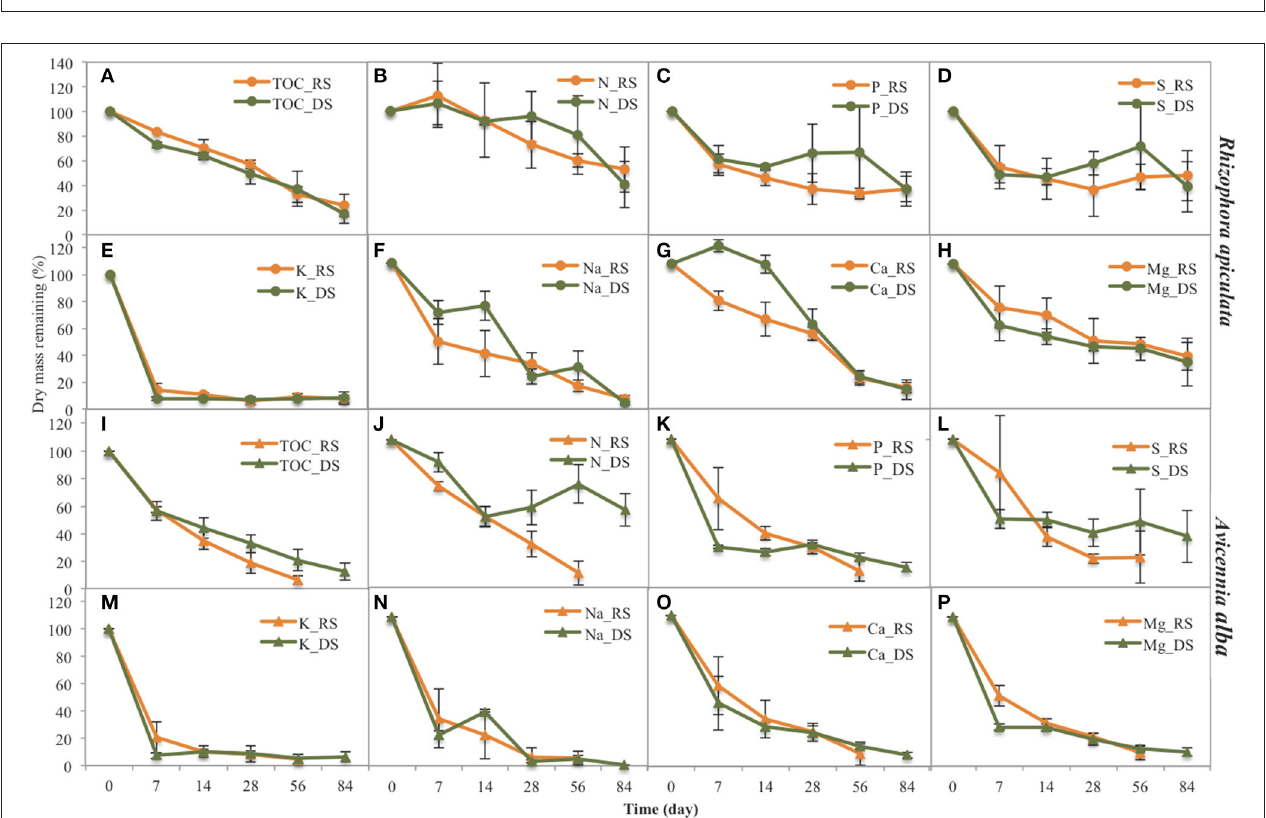
FIGURE 4 | Remaining dry mass of several elements during leaf litter decomposition of the two species studied ( Rhizophora and Avicennia ) and at the two seasons (RS: rainy season, DS: dry season). (A) TOC for Rhizophora , (B) N for Rhizophora , (C) P for Rhizophora , (D) S for Rhizophora , E K for Rhizophora , (F) Na for Rhizophora , (G) Ca for Rhizophora , (H) Mg for Rhizophora , (I) TOC for Avicennia , (J) N for Avicennia , (K) P for Avicennia a, (L) S for Avicennia a, (M) K for Avicennia a, (N) Na for Avicennia , (O) Ca for Avicennia a, (P) Mg for Avicennia .